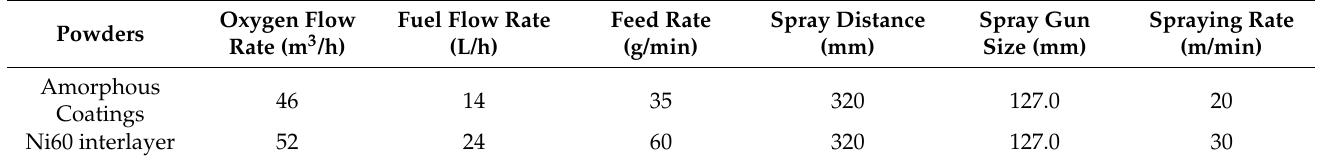
Table 2. Spraying parameters of the HVOF